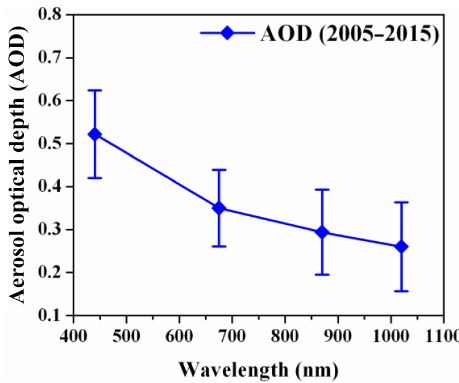
Figure 5. Composite spectral AOD variations from one-decade Cimel measurements in Pune, India. The vertical bar at each data point represents the standard deviation from the mean.